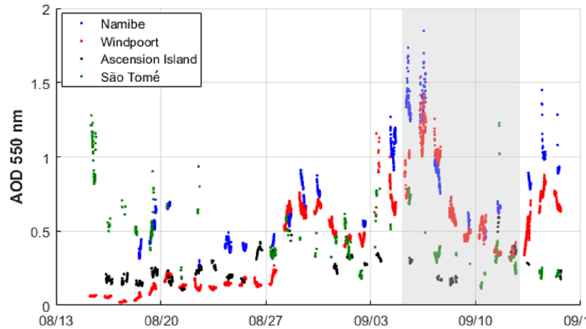
Figure 5. AOD time series measured at 550nm at Namibe, Wind- poort, Ascension Island, and São Tomé AERONET sites from 13 August to 16 September 2017. The grey zone represents the flight period of the AEROCLO-sA